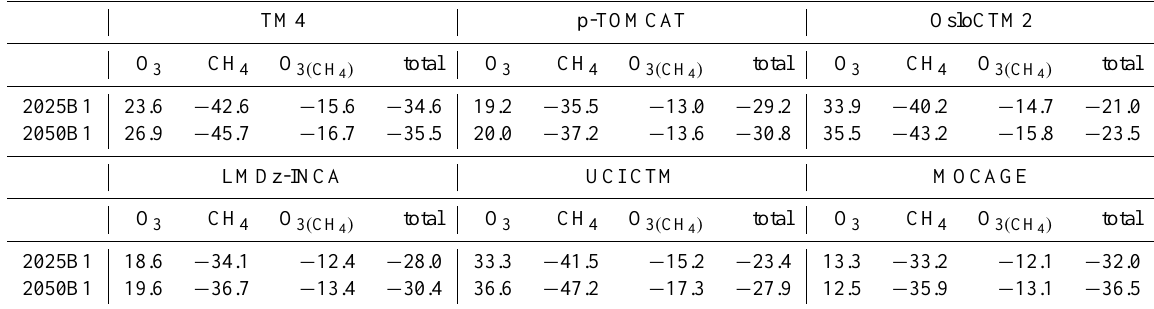
Table B4. Same as Table B3, but due to emissions from